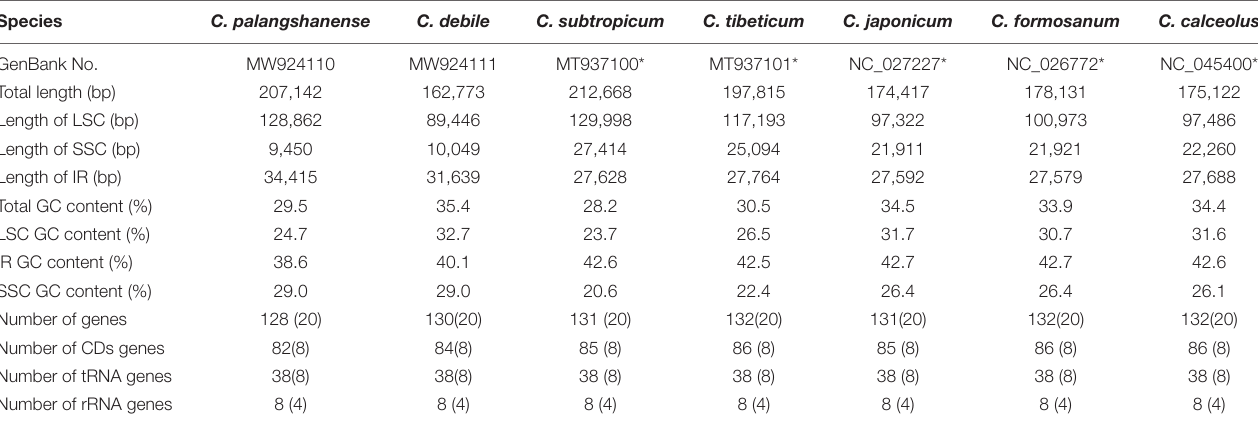
FIGURE 1 | Chloroplast genome maps of C. palangshanense (A) and C. debile (B) . Genes of different functional groups are shown in colored bars. The inner circle (dashed gray area) indicates the proportional GC content of the corresponding genes. Regions of the large single-copy (LSC), small single-copy (SSC) and inverted repeats (IRA and IRB) are indicated. TABLE 1 | General characteristics of the chloroplast genomes of the seven Cypripedium species.